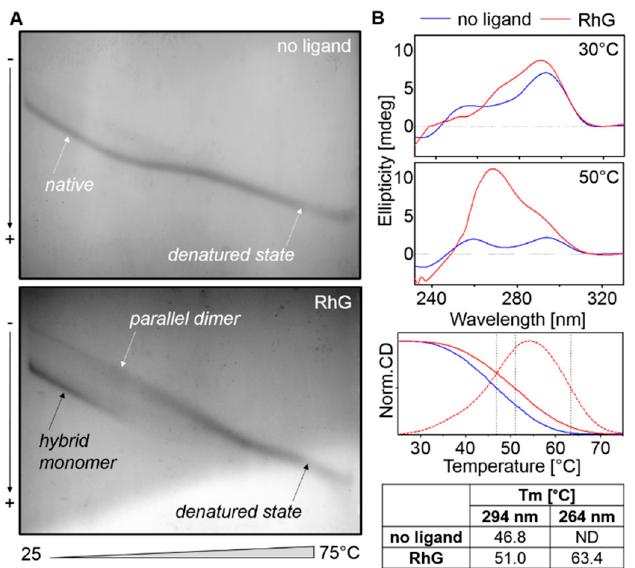
Figure 6. ( A ) TGGE record of HTR sequence in 25 mM mBR, pH 7.0 supplemented with 2.5 mM KCl (up). The corresponding electrophoretic result contained 260 µM of Rh6G (down). ( B ) CD spectra under the same conditions as the TGGE assay in the presence and absence of RhG. The temperature dependences were obtained at 264 (red dashed line) and 294 (solid lines) nm. CD melting temperatures are shown in the enclosed table. These temperatures agree with those obtained with TGGE: 46.5 °C and 50.6 °C for antiparallel G4 in the absence and presence of RhG, respectively, and >62 ± 2 °C for parallel G4 with RhG.